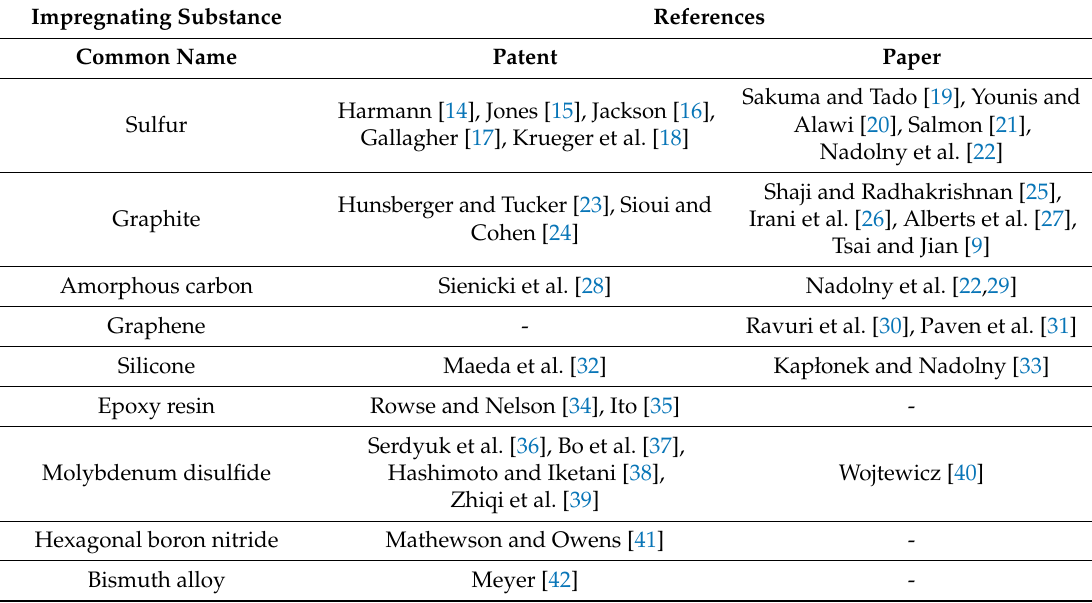
Table 1. Substances used for the impregnating process of grinding